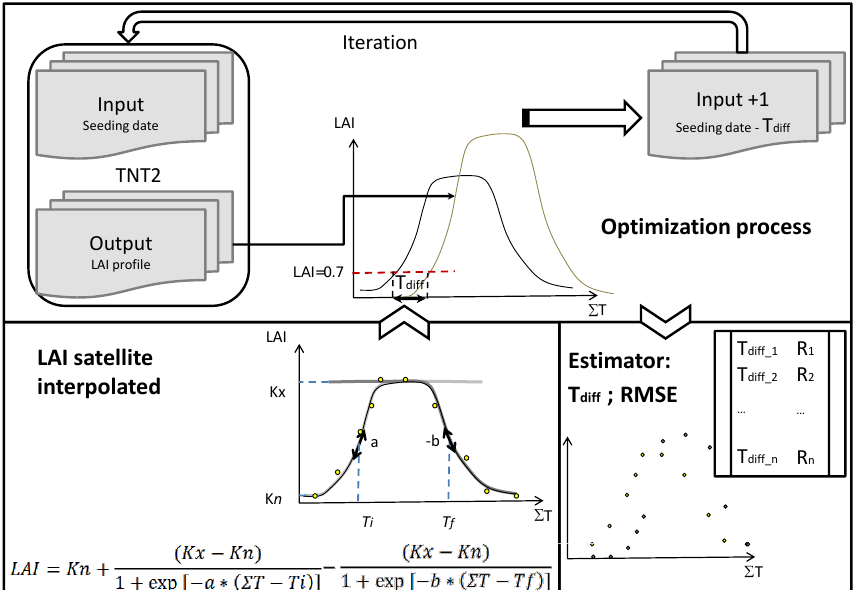
Figure 2. Process of optimization of the seeding date by matching the early variations of simulated LAI with the interpolated LAI derived from F2 image series at crop-field scale. The interpolated LAIs are obtained by fitting a double logistic equation against discrete satellite- derived LAI at the crop-field scale. The equation describing the growth of the LAI depends on the cumulative daily temperature (cid:54) T. Kn and Kx are the minimum and maximum of the interpolated LAI, respectively. Ti and Tf are the cumulative temperature when the LAI reaches Kx/2 during the growth and the senescence phases, respectively. Parameters a and b correspond to the local slope of the temperatures Tf and